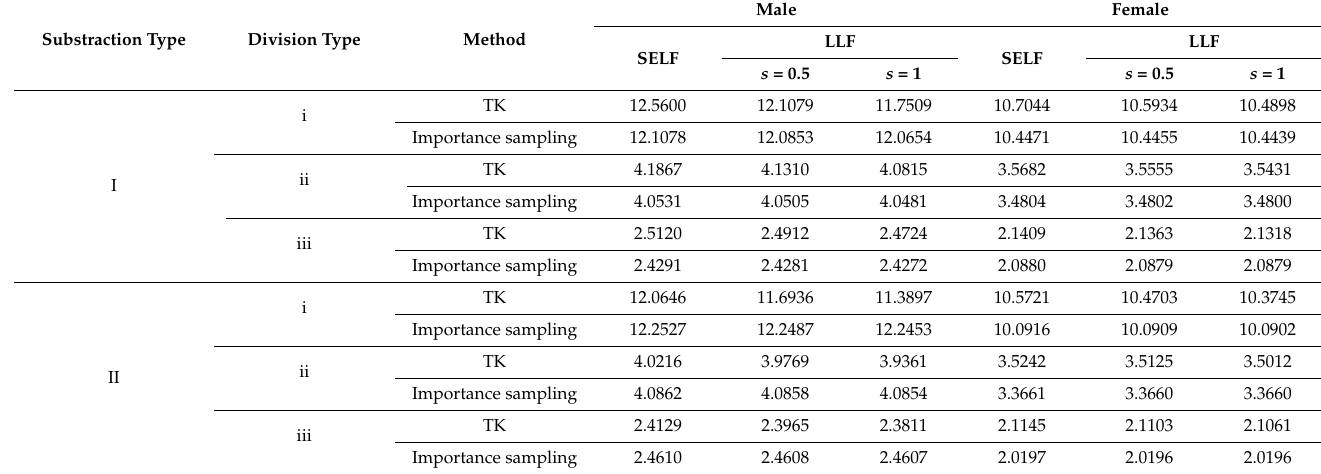
Table A8. The results of Bayesian estimates for σ using TK approximation and importance sampling.